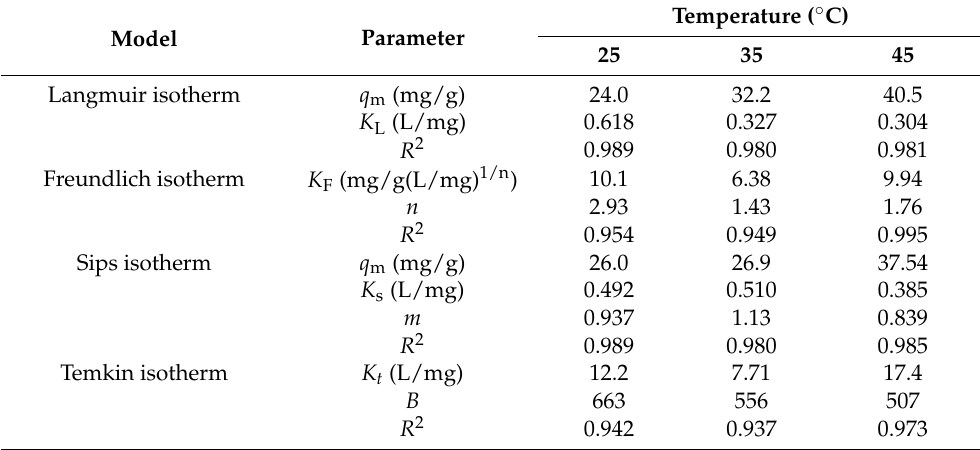
Table 3. Adsorption isotherm model parameters for TE on